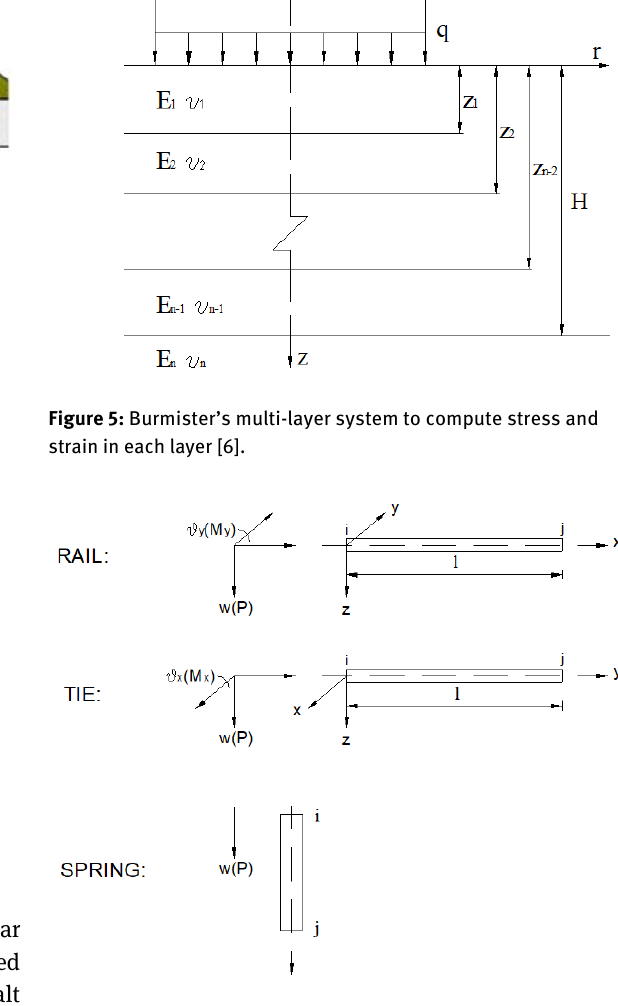
Figure 6: Finite Element Method for the rail and sleepers stress- strain analysis